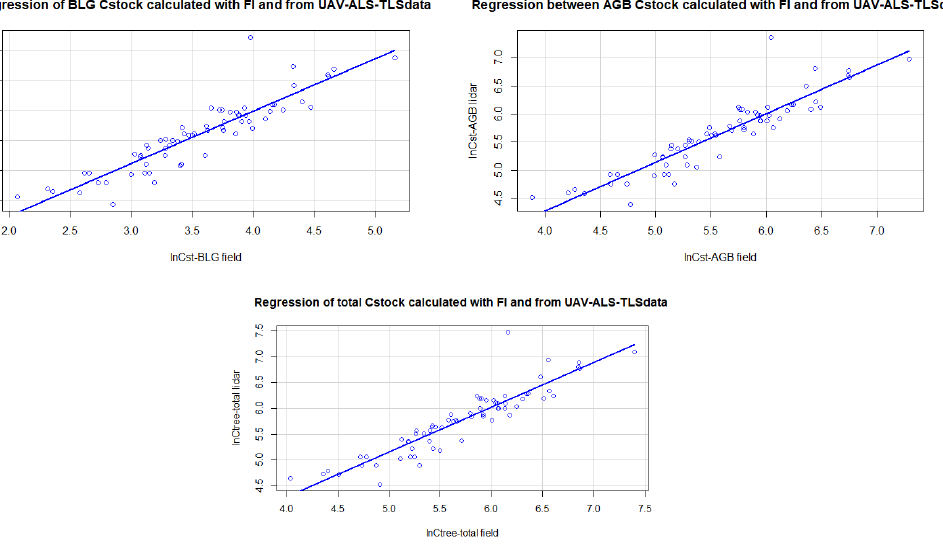
Figure 13. Relationship between aboveground, belowground, and total carbon stock calculated with two types of inputs (forest parameters from field measurements and those extracted from UAV-ALS and TLS data), represented using linear regression with logarithmic transformation.